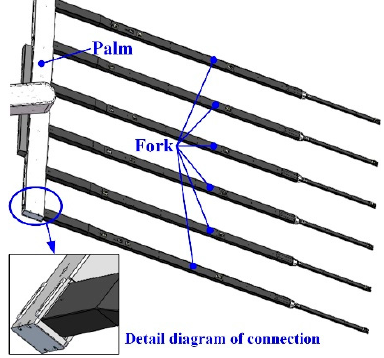
Figure 2. The construction of the end effector.